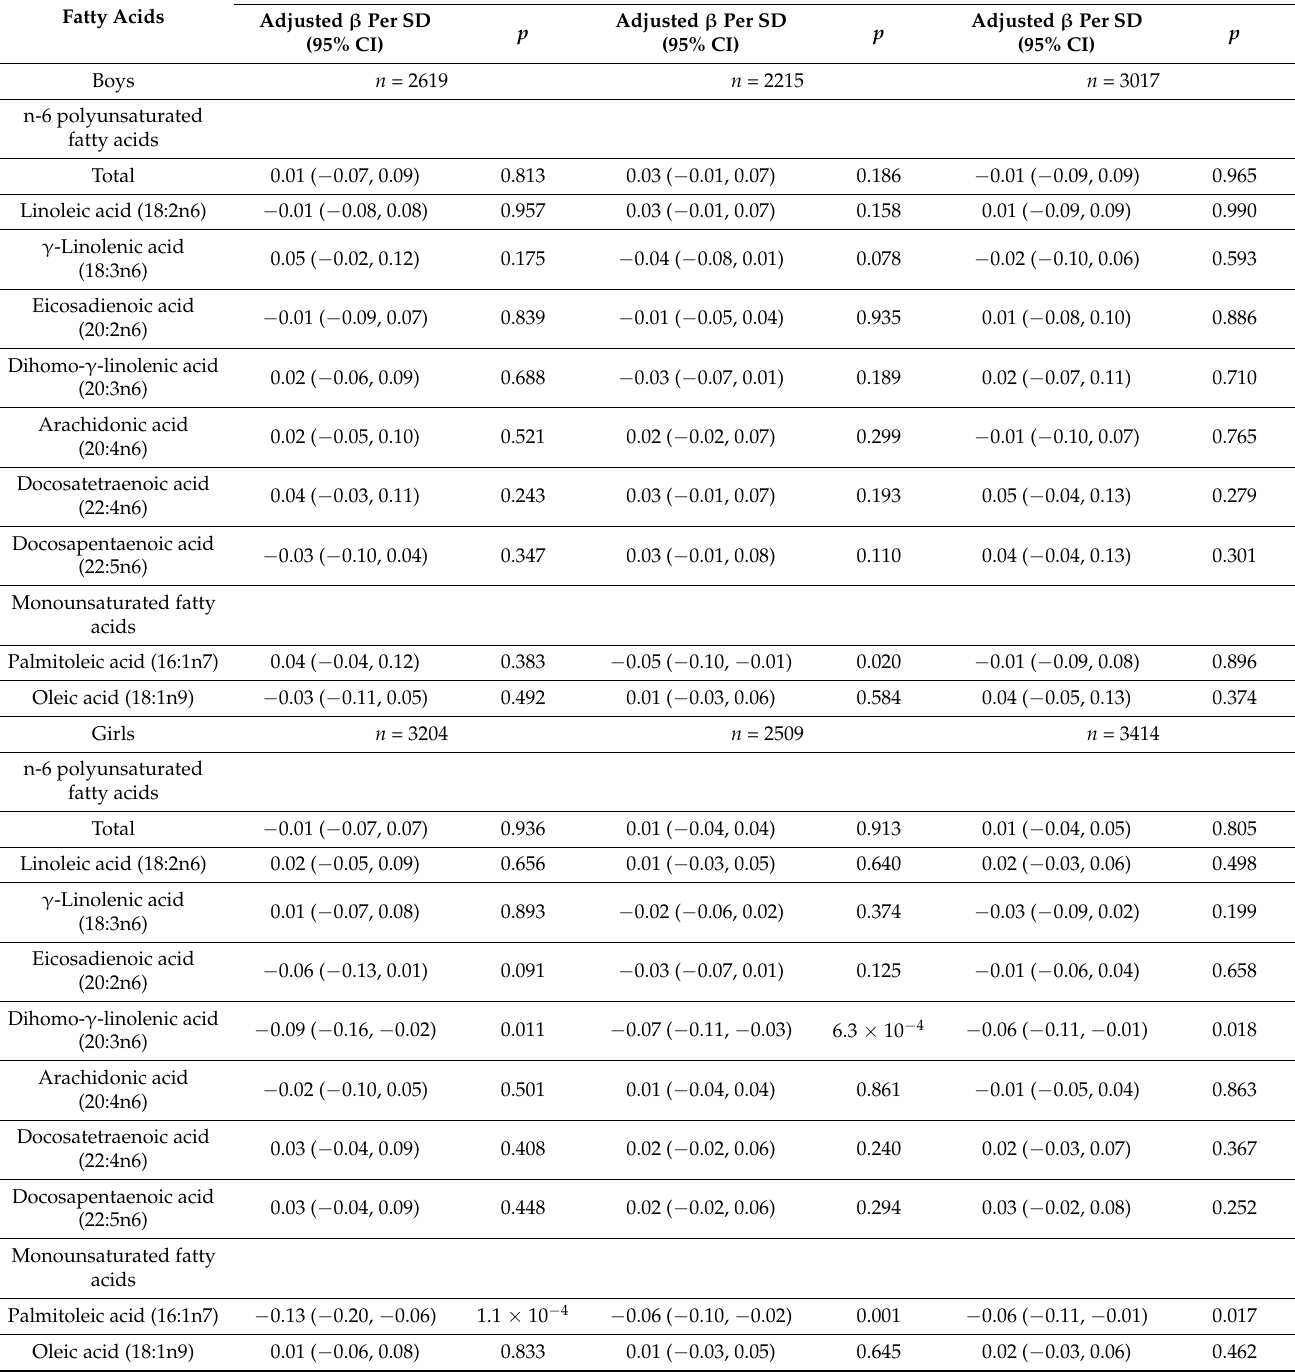
Table 3. Associations of plasma phospholipid fatty acids at 7.5 years with puberty timing in the ALSPAC study 1 . Age at Genital/Breast Fatty Acids